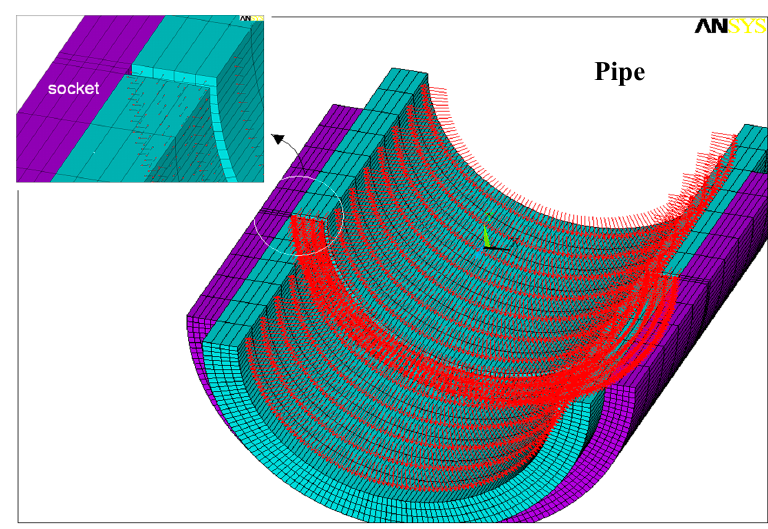
Figure 3. Typical finite element model of pipe and socket subjected to internal pressure.